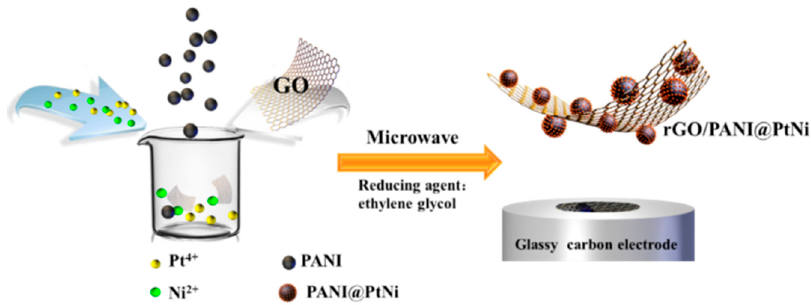
Figure 1. Scheme of fabricating the modified glassy carbon electrode (GCE) with platinum-nickel decorated polyaniline nano-spheres (rGO/PANI@PtNi) nanocomposite.